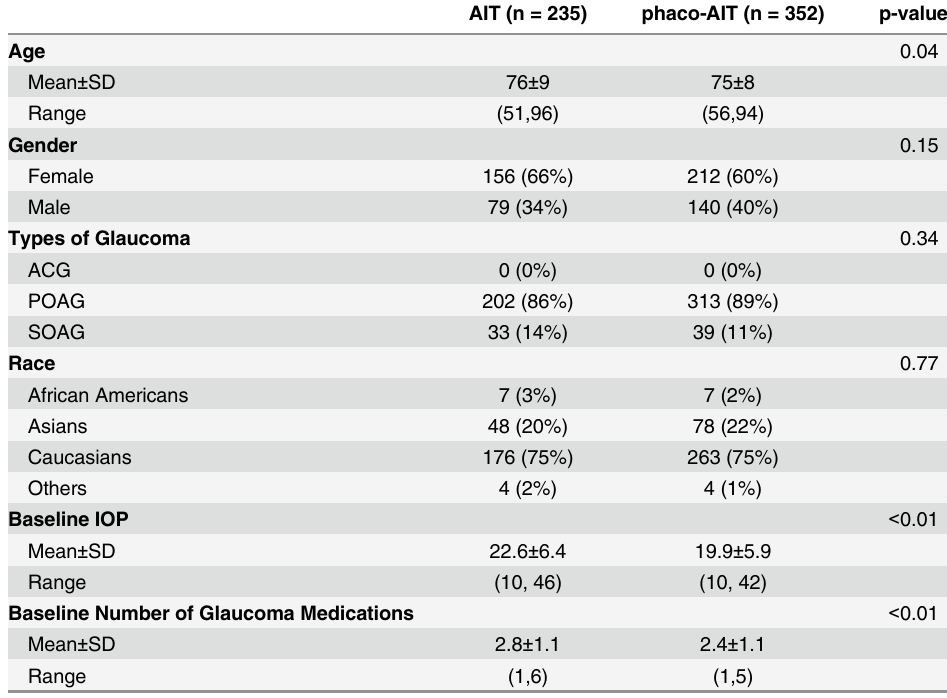
Table 2. Matched data demographics of study population. Matched data is shown for both AIT-only and phaco-AIT group demographics.